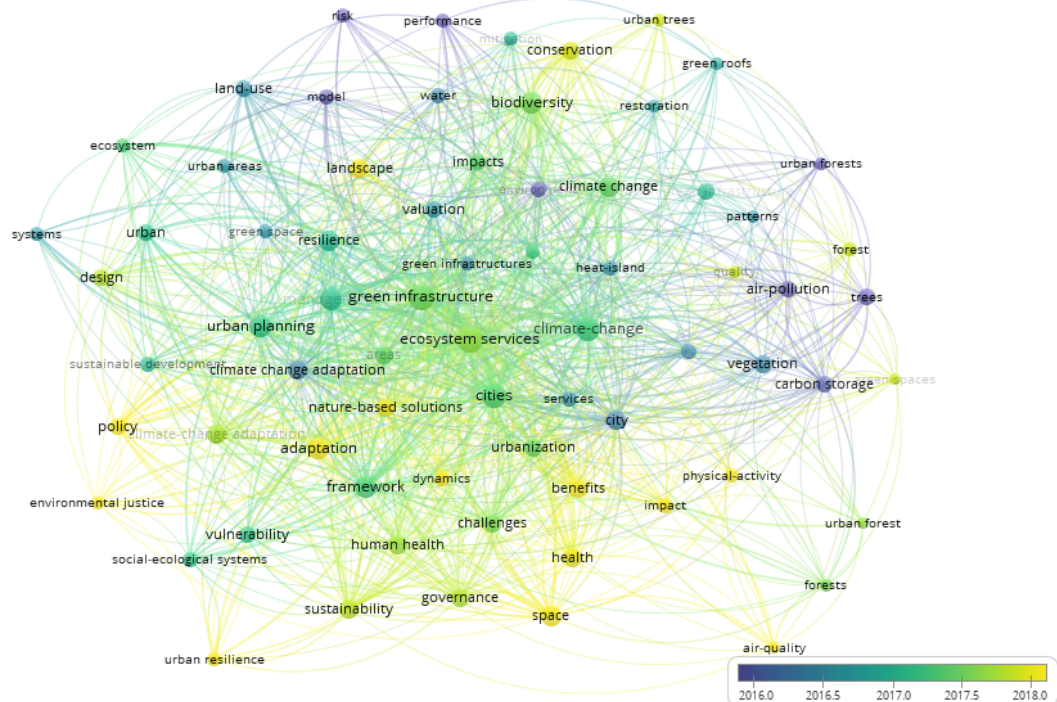
Figure 4. Overlay Visualization of Future Trends by all Keywords. Source: VOSviewer. Own Compilation.